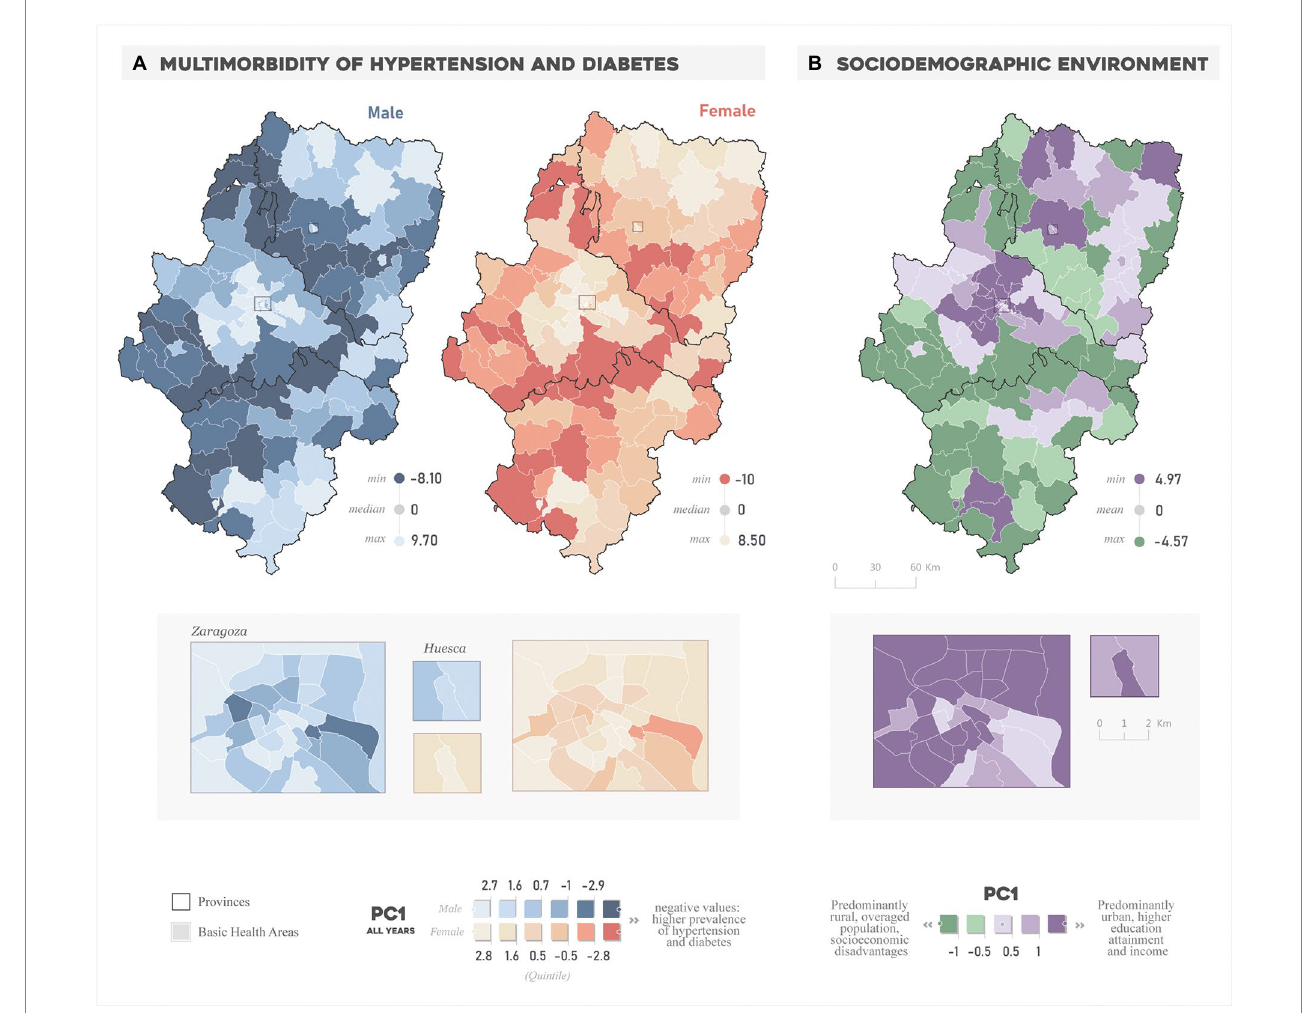
FIGURE 2 Spatial distribution of the (A) “All years” multi-morbidity PC and the (B) sociodemographic environment PC.